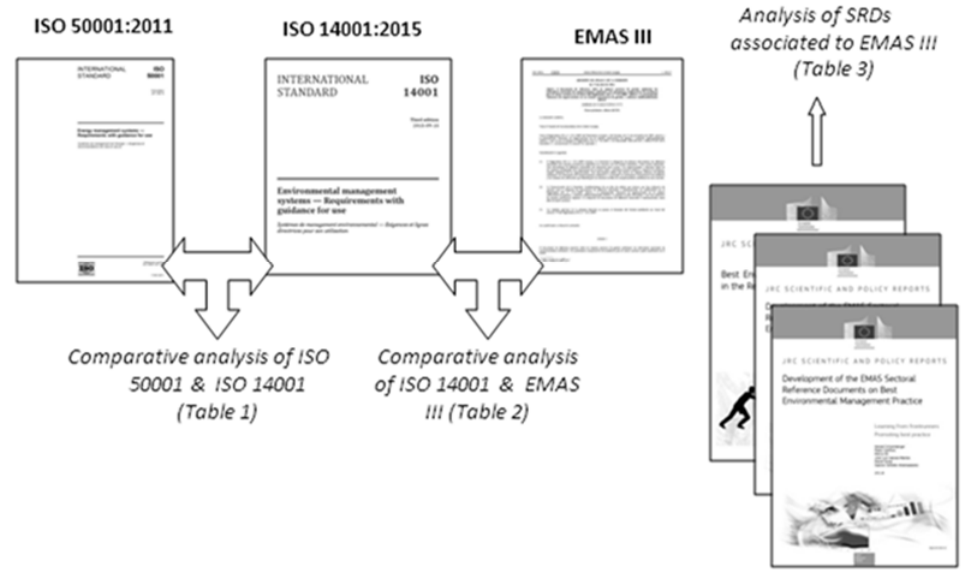
Figure 1. Summary of the research framework, main specific documents analyzed and main findings.